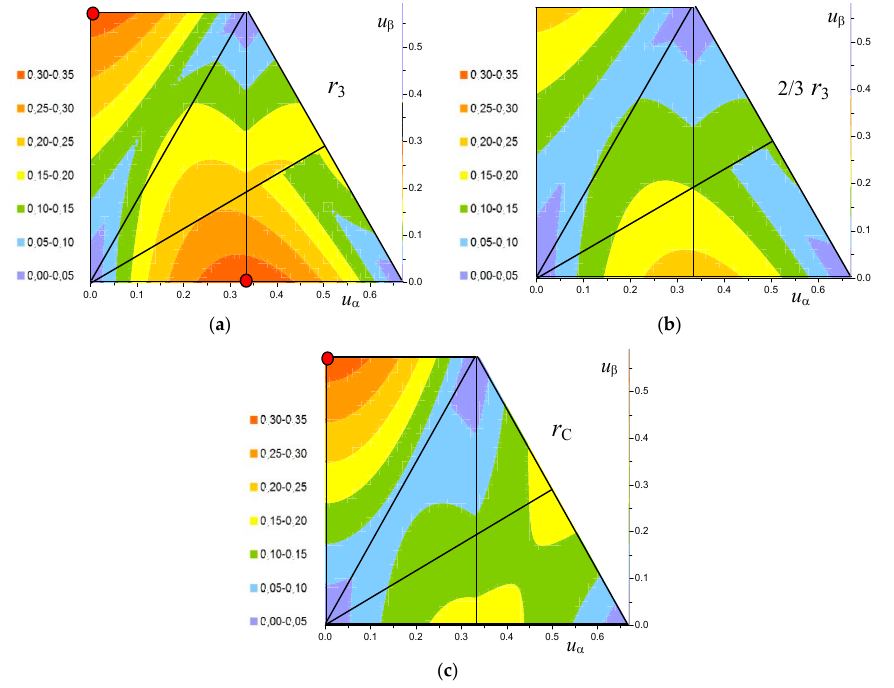
Figure 17. Maps of normalized current ripple in the normalized output voltage plane: ( a ) DPWM3; ( b ) DPWM3 scaled by 2/3; and ( c ) CPWM.